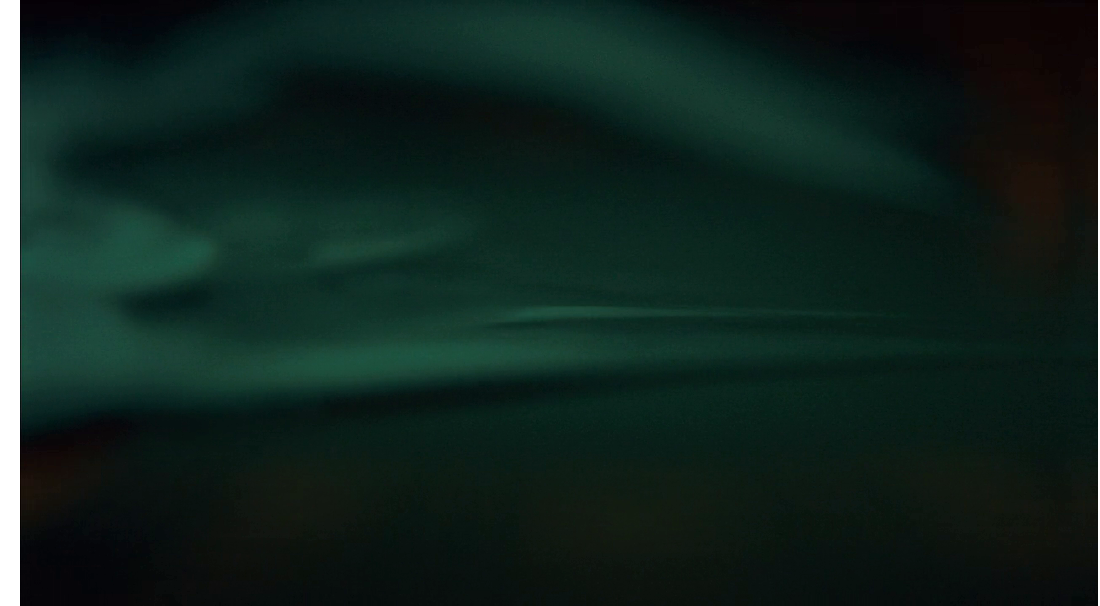
Figure 4. The symbolic beginning of the “nigredo” stage rendered by dark green colour palette at the beginning of the third season of the series, right after the flashback from season 2. Symbolically, the visual is also a reminder that the first half of season 3 is “really about the afterlife,” mostly “in the sense of life after trauma,” which irrevocably changes the characters, including Hannibal (MM). The key of Hannibal’s motorbike is put into ignition. The fumes are reminiscent of Zephyrus’s angry/ furious breath. Screencap from Hannibal , season 3, episode 1, “Antipasto,” directed by Vincenzo